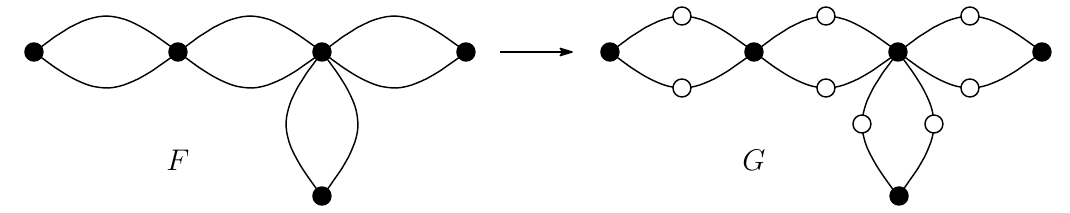
Figure 1: A duplicated base-tree F and a C